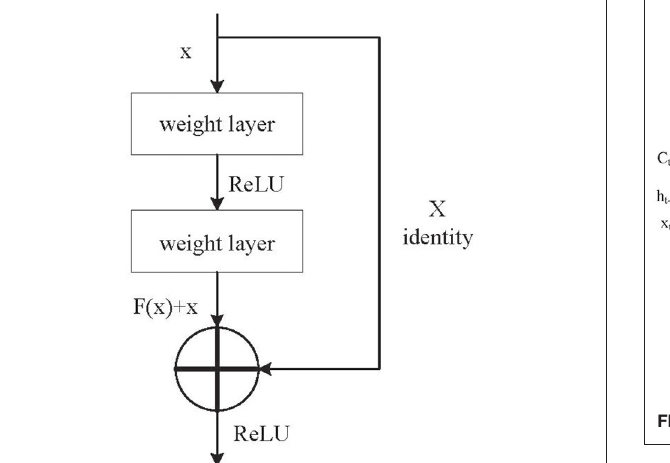
FIGURE 3 | The residual block structure of ResNet.